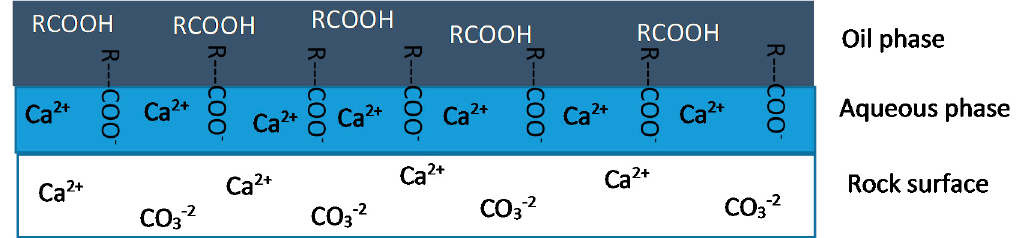
Figure 2. Simple schematic to illustrate the interaction between stearic acid and calcium carbonate in a three-phase